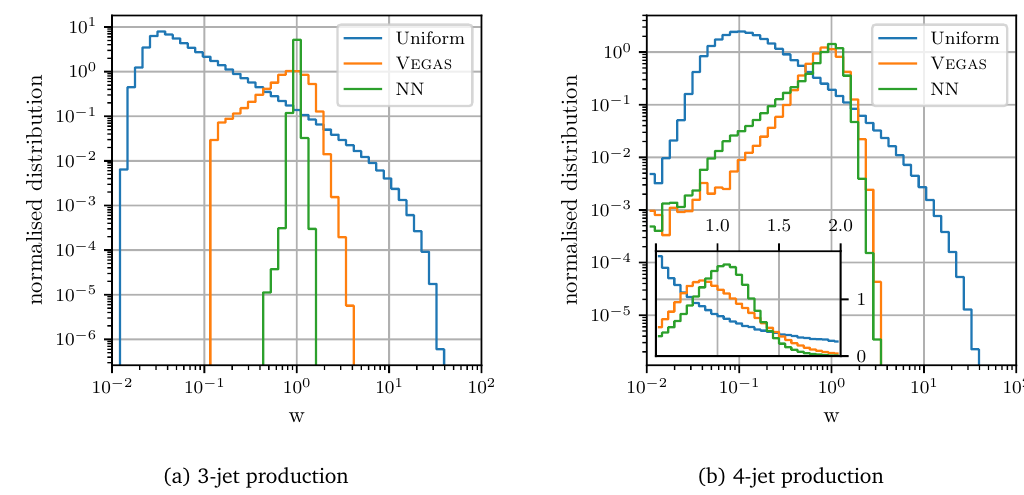
Figure 4: Event weight distributions for sampling the total cross section for gg → n (cid:112) s = 1TeV with N = 10 6 points, comparing V EGAS optimisation, NN-based jets for optimisation and an unoptimised (“Uniform”) distribution. Note that we now use a logarithmic scale for the x axis. The inset plot in (b) shows the peak region in more detail and using a linear scale.